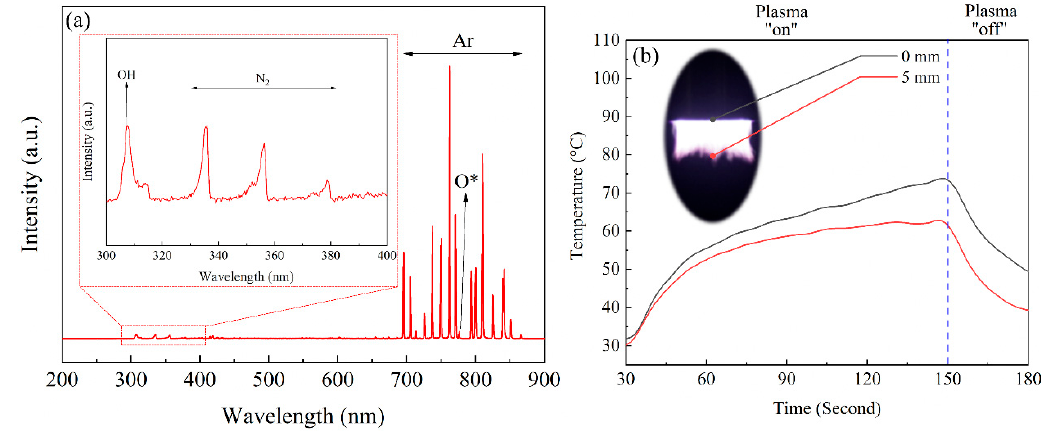
Figure 1. ( a ) OES obtained from Ar-APPJ process, ( b ) argon plasma with a plume length of 5 cm and gas temperature.